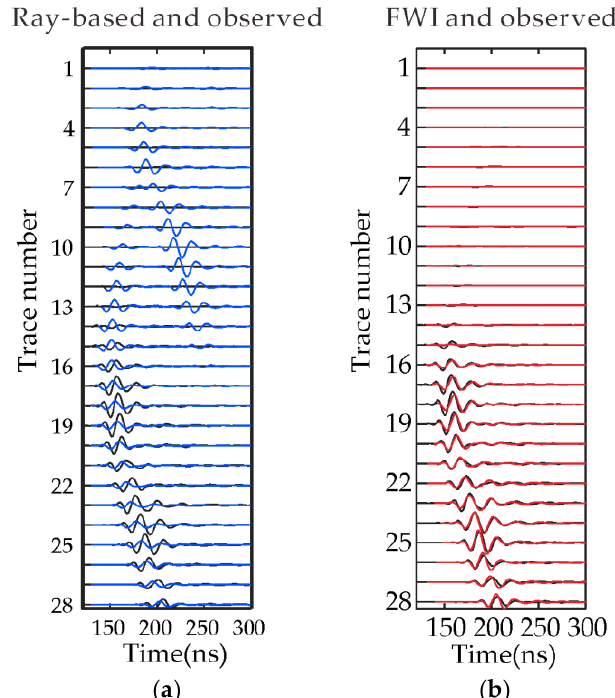
Figure 10. Waveform comparisons for receiver gathers when the source is at the depth of 63.5 m: ( a ) The solid and dashed lines show the observed radar traces and data generated from the ray-based results; ( b ) the solid and dotted lines show the observed radar traces and data from the FWI results. Amplitudes in all panels are normalized with respect to the maximum amplitude of the field data.